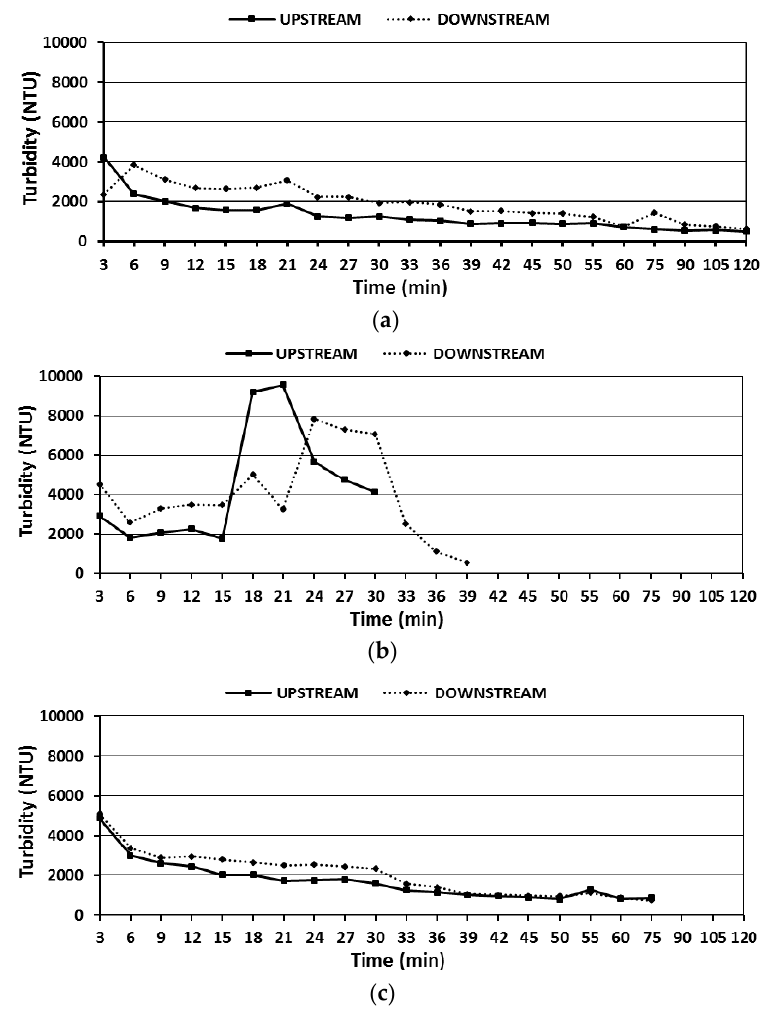
Figure 5. Average turbidity over time for each silt fence installation tested, ( a ) ALDOT Trenched Silt Fence , ( b ) ALDOT Sliced Silt Fence , ( c ) AL-SWCC Trenched Silt Fence.